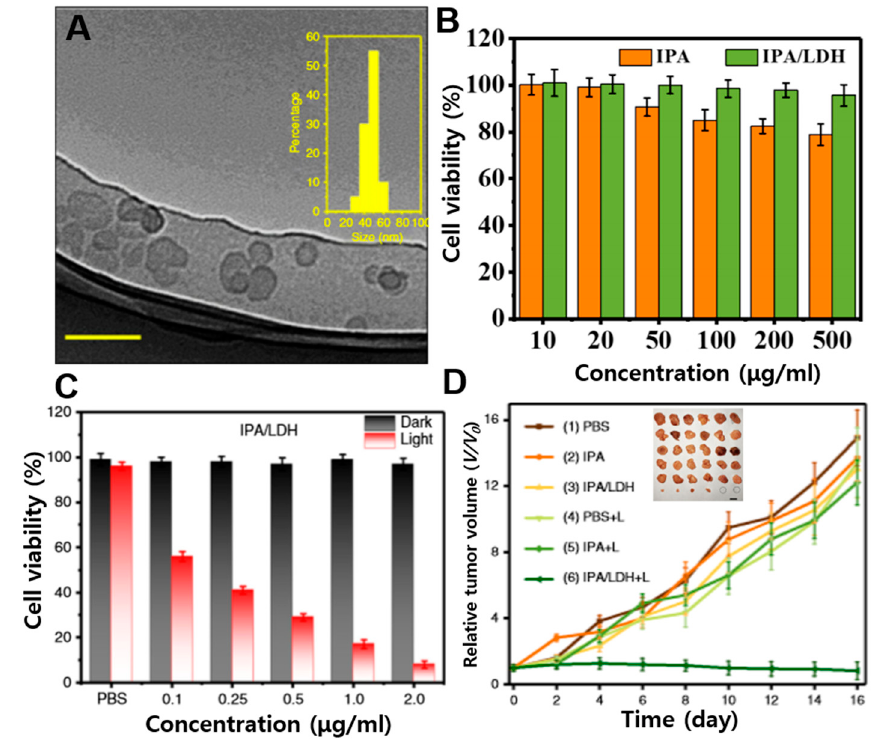
Figure 5. ( A ) TEM image and size distributions (inset) of IPA / LDH. ( B ) Cell viabilities of cells following incubation with various concentrations of IPA and IPA / LDH. ( C ) MTT assay of cell viabilities with and without irradiation incubated with IPA / LDH. ( D ) Tumor growth curves of mice with the various treatments and corresponding images of tumors taken on 16 d treatment (insert), reproduced from reference [19].